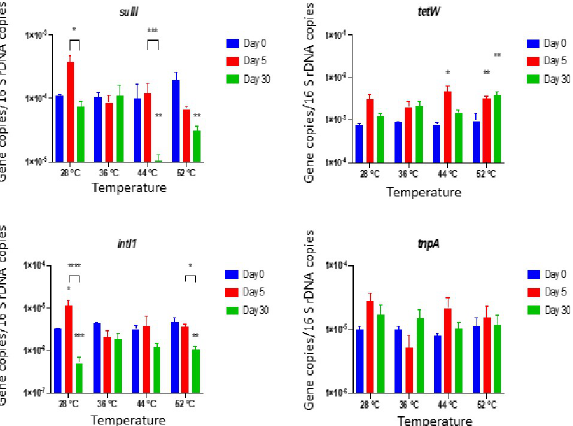
Fig 3. Relative abundance of ARGs and MGEs detected at Day 0, 5, 30 during anaerobic digestion. Values represent the means based on three replicates. Bars represent standard errors. Symbol and meaning: P � 0.05( � ); P � 0.01( �� ); P � 0.001( ��� ); P � 0.0001( ����